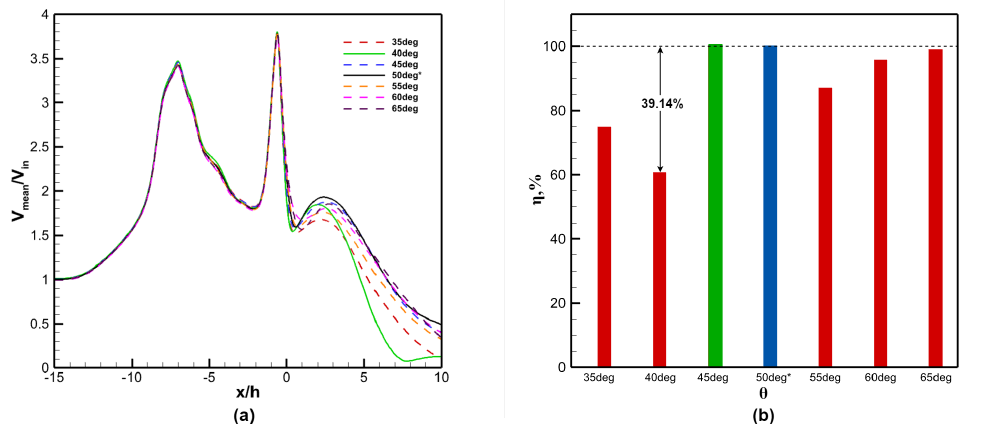
Figure 12. ( a ) Mean velocity along the centerline normalized by the inlet velocity, V in , Baseline ; ( b ) velocity ratio, η , at point x/h = 5 for the angular